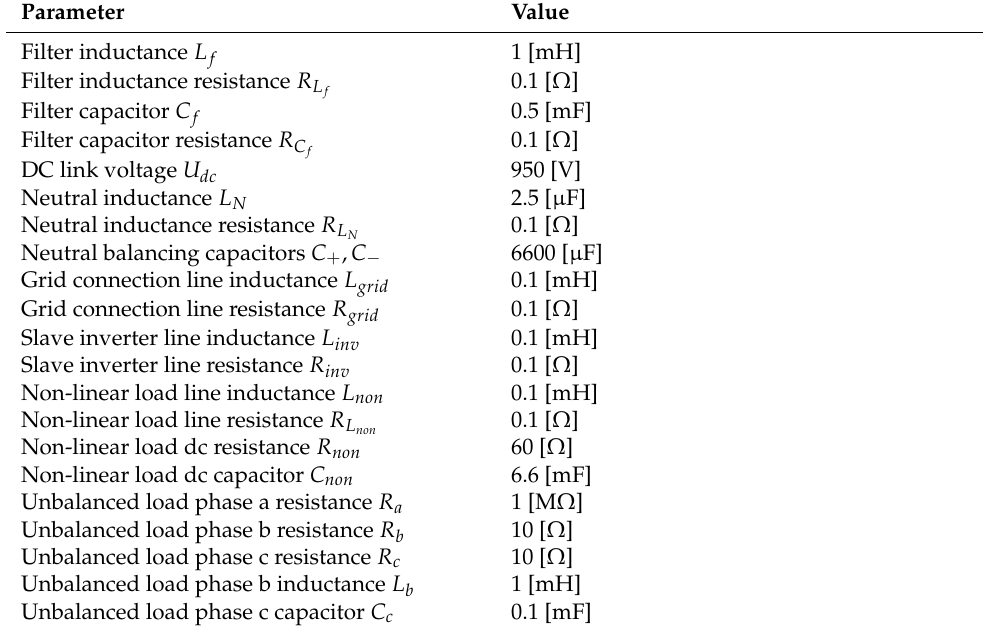
Table 1. Components